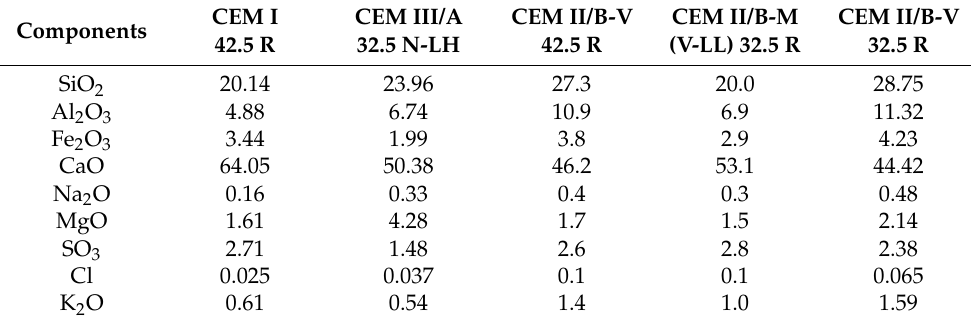
Table 1. Chemical composition of cements.